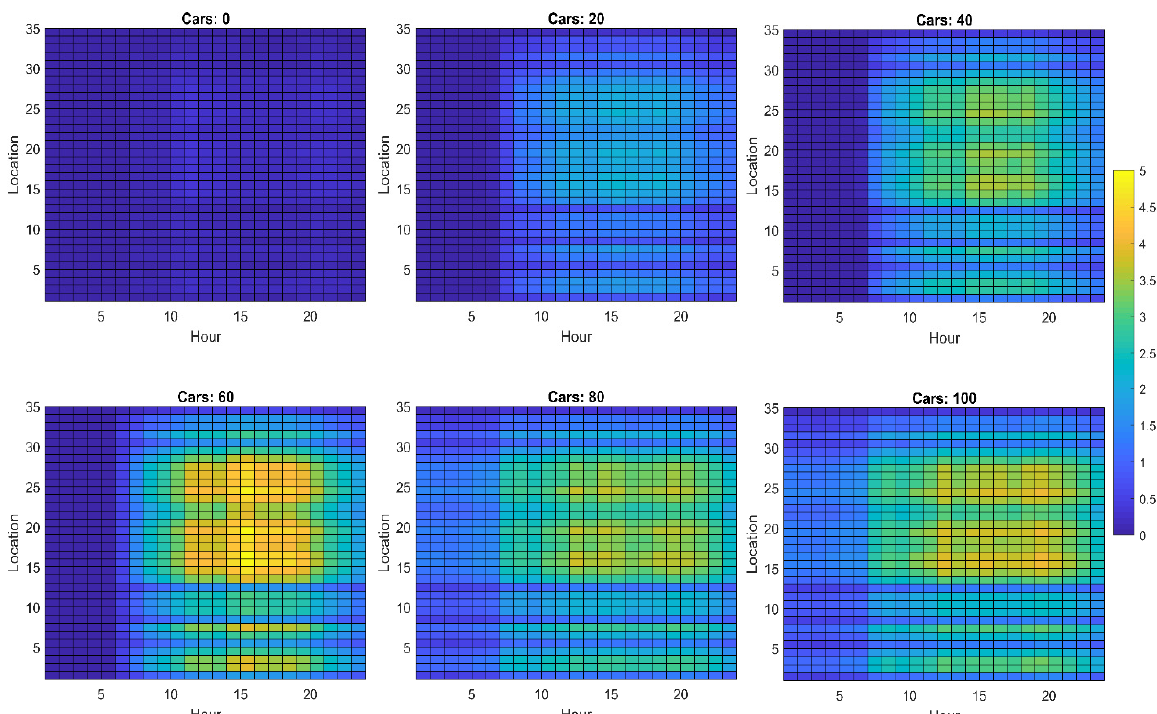
Figure A4. Maximum voltage drops (percentage) observed across network 2 by varying EV penetration and time of day.